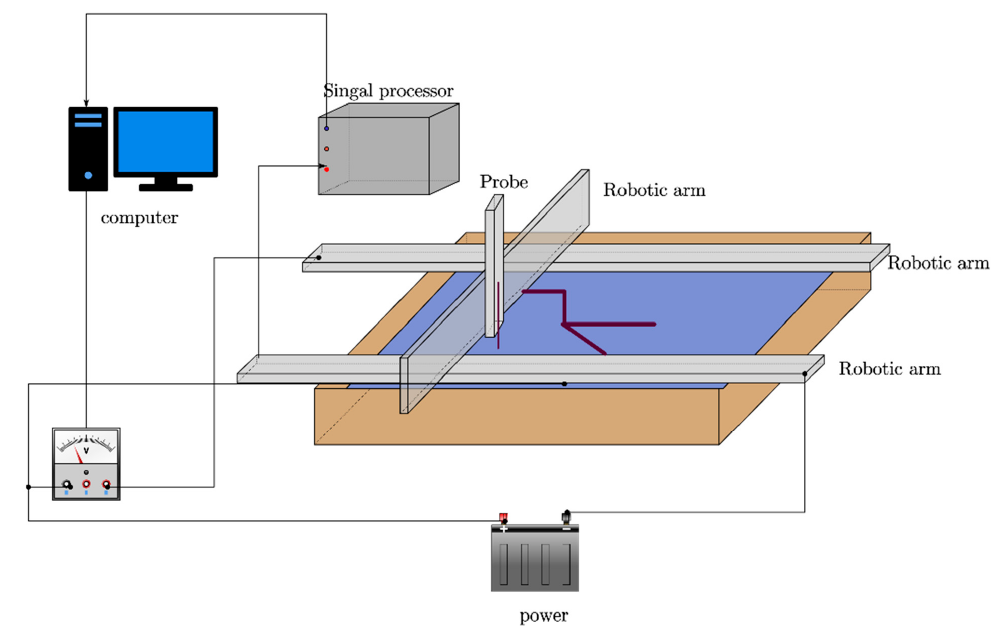
Figure 6. Physical diagram of electric simulation experiment.